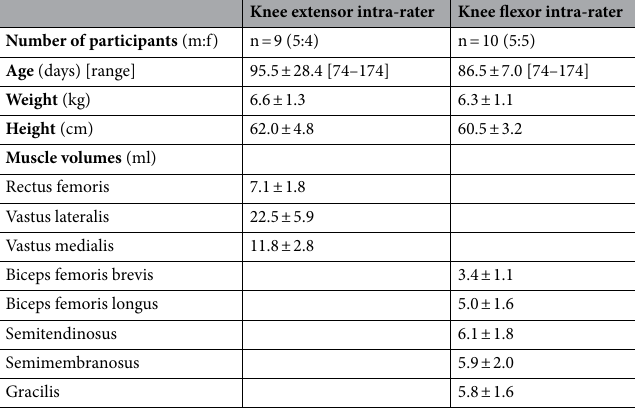
Table 1. Participant demographics and anthropometric measures of participant subgroups. Data are presented by mean ± standard deviation, calculated by the measurement of the second round of digitising for each rater.